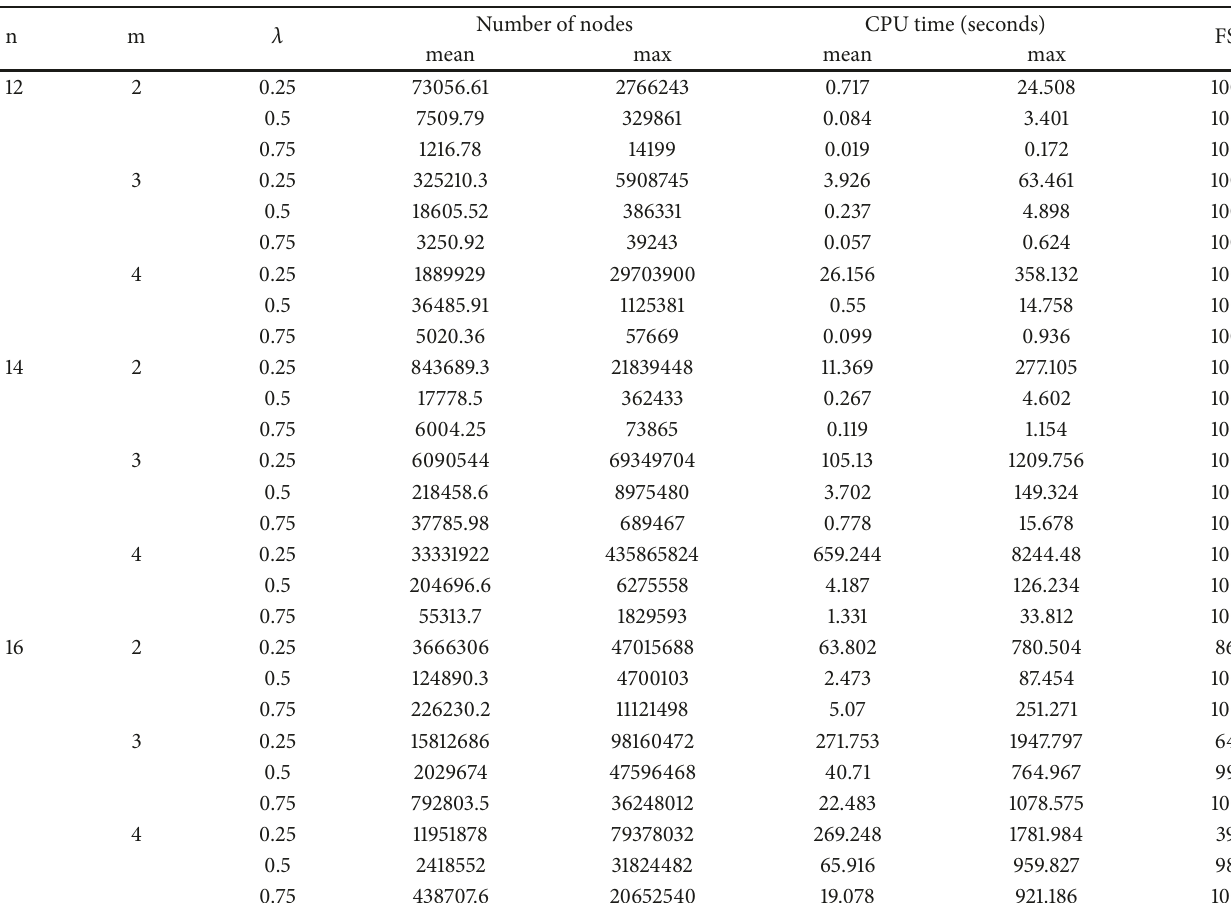
Table 2: Computational results of the branch-and-bound method.